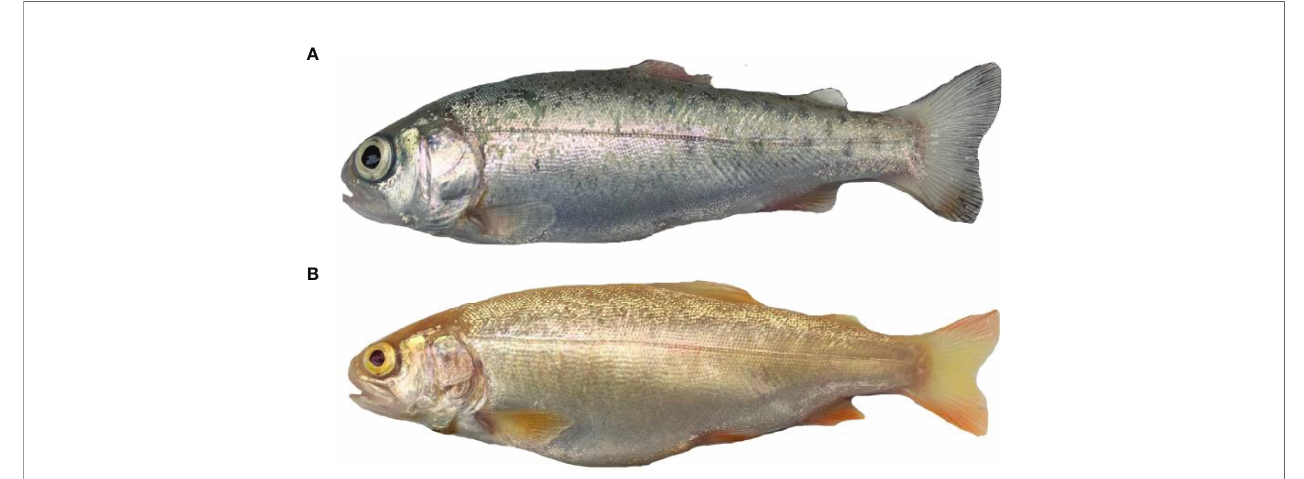
FIGURE 1 | Two phenotypes of rainbow trout. (A) Wild-type rainbow trout (WR_S). (B) Yellow mutant rainbow trout